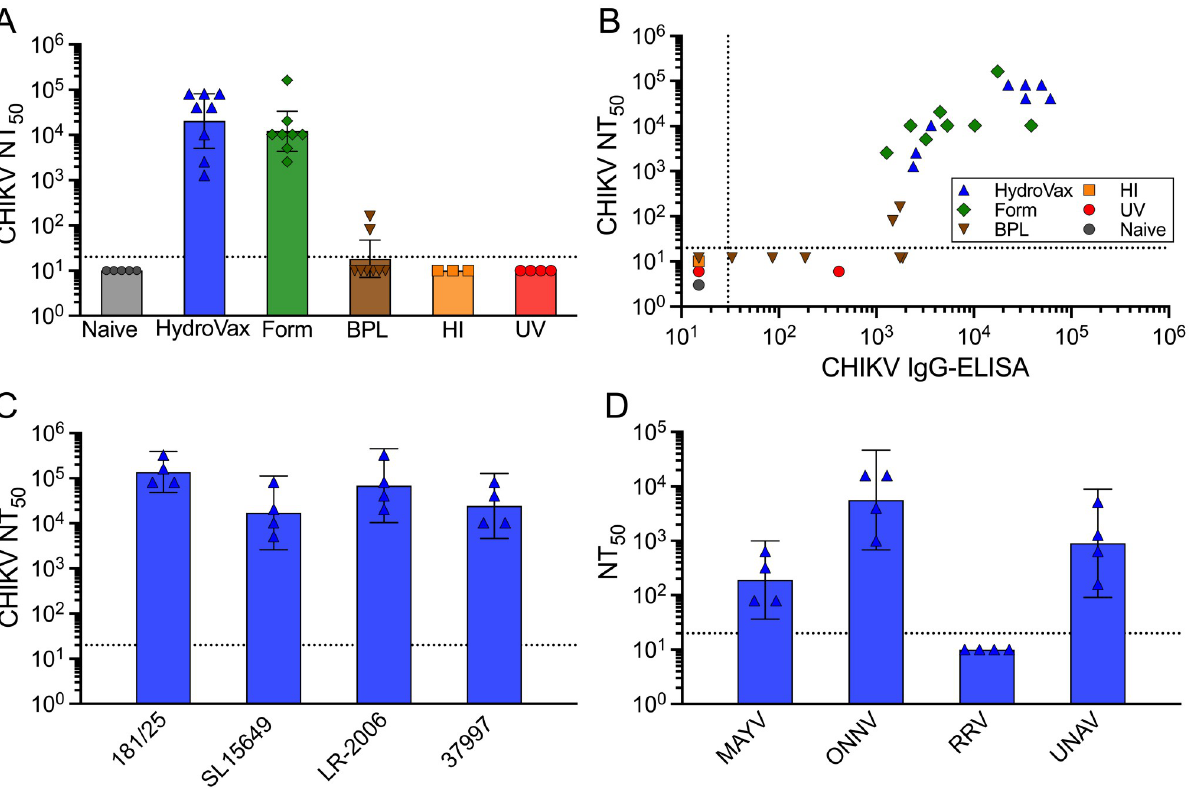
Fig 3. HydroVax-CHIKV induces antibody responses against heterologous CHIKV strains in addition to other arthritogenic alphaviruses including MAYV, ONNV, and UNAV. (A) Purified CHIKV-181/25 was inactivated with the optimized HydroVax approach (20 hours at room temperature), formaldehyde (Form., 0.01% for 20 days at 37˚C), β -propiolactone (BPL, 0.10% for 20 hours at room temperature), heat inactivation (HI, 1 hour at 80˚C) or ultraviolet irradiation (UV, 10J). C57BL/6 mice ( n = 5–8 per group) were immunized on days 0 and 28 with 0.5 μ g of the optimized HydroVax-CHIKV, 0.5 μ g of Formaldehyde-inactivated virus, a 2 μ g dose of BPL-inactivated virus or a 5 μ g dose for heat-inactivated or UV-irradiated virus. Serum samples were collected on day 56 and assessed for vaccine-homologous CHIKV-181/25 neutralizing activity. (B) Serum samples were assessed for neutralizing activity and virus-binding antibody titers to CHIKV-181/25 as determined by ELISA. Neutralizing titers below the limit of detection (NT 50 < 20) were given arbitrary values to allow visualization of individual symbols within the graph. (C) Mice immunized with HydroVax- CHIKV on days 0 and 28 (ranging from 0.8–2 μ g per dose) were tested for homologous and heterologous CHIKV-specific neutralizing activity at 56 days following the primary vaccination (28 days following booster vaccination). (D) The serum samples examined in panel C were tested for neutralizing activity against Mayaro virus (MAYV), O’nyong’nyong virus (ONNV), Ross River virus (RRV), and Una virus (UNAV). Each individual data point is shown along with the geometric mean represented by a bar and 95% confidence intervals. Dotted lines represent the limit of detection.